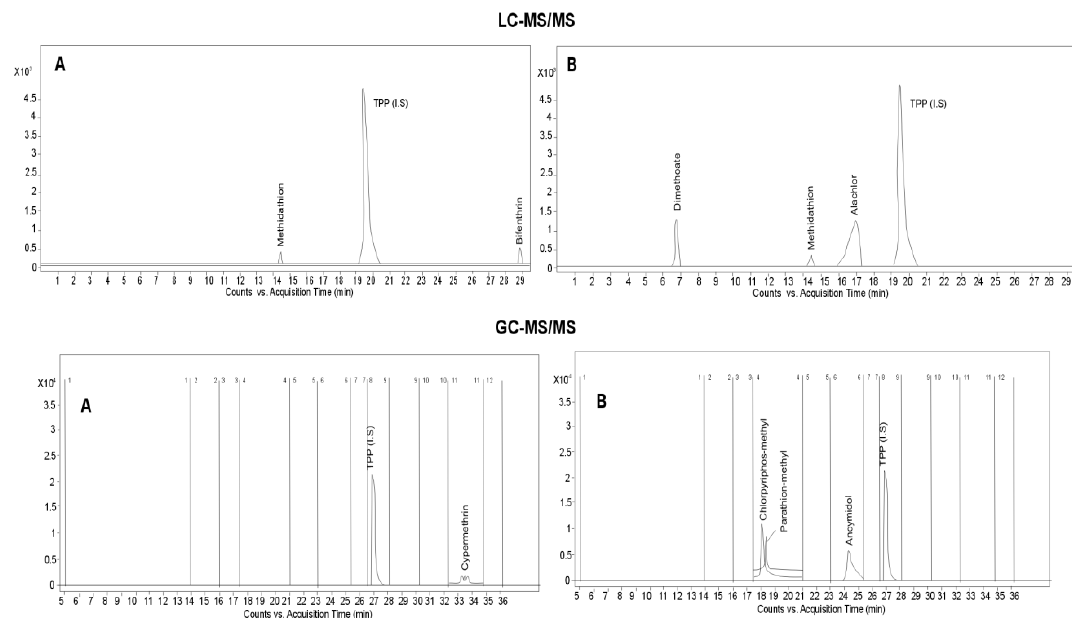
Figure 4. The sample chromatograms obtained during analysis of extracts from real sample in which selected pesticide residues was detected above MRLs level: A —honey samples, B —honeybee samples.